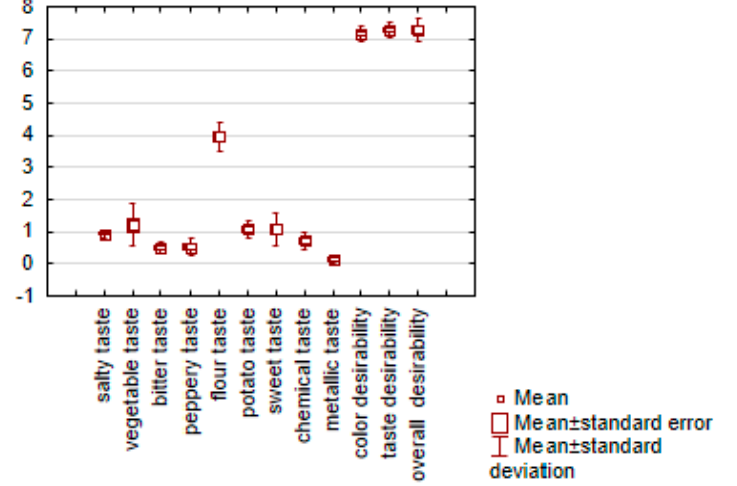
Figure 4. Box plot diagram of consumer desirability (color, taste and overall desirability) and attributes of taste profiles of gnocchi dumplings with thiamine hydrochloride and thiamine pyrophosphate carriers (Muscat Pumpkin, Hokkaido Pumpkin, Cauliflower, Broccoli) and the control sample (without carriers).